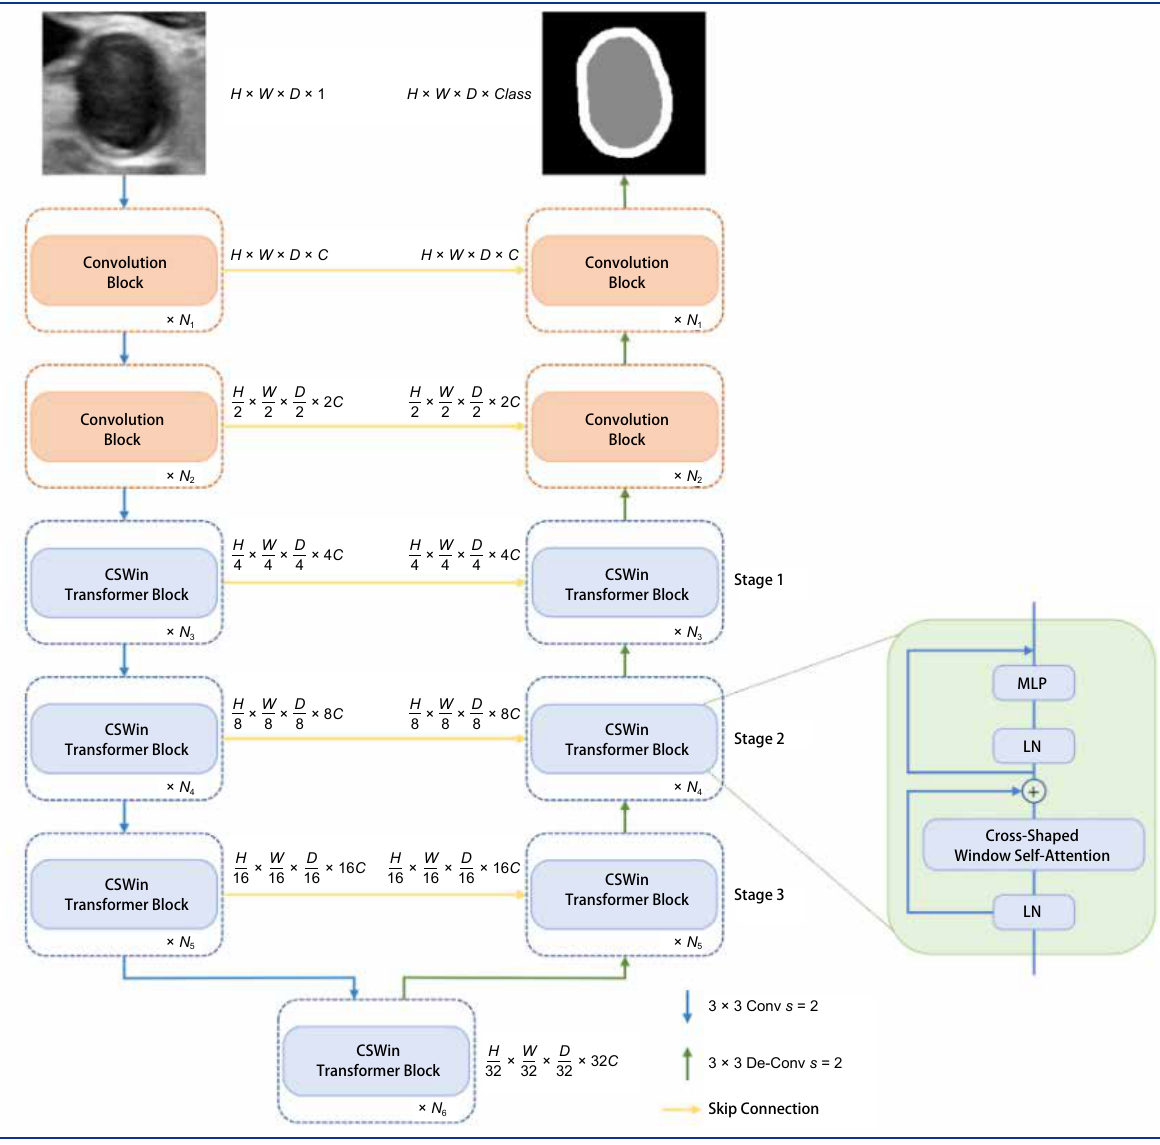
Figure 5 U-CSWT network and CSWT module